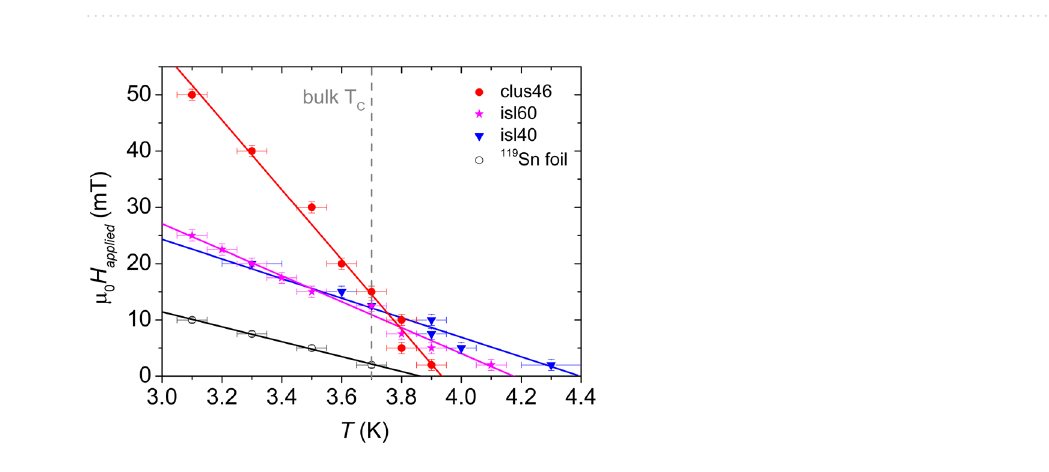
Figure 2. Magnetic moment ( m ) as a function of temperature after zero-field cooling for different applied magnetic fields for: ( a ) 119 Sn reference foil and ( b ) clus46.